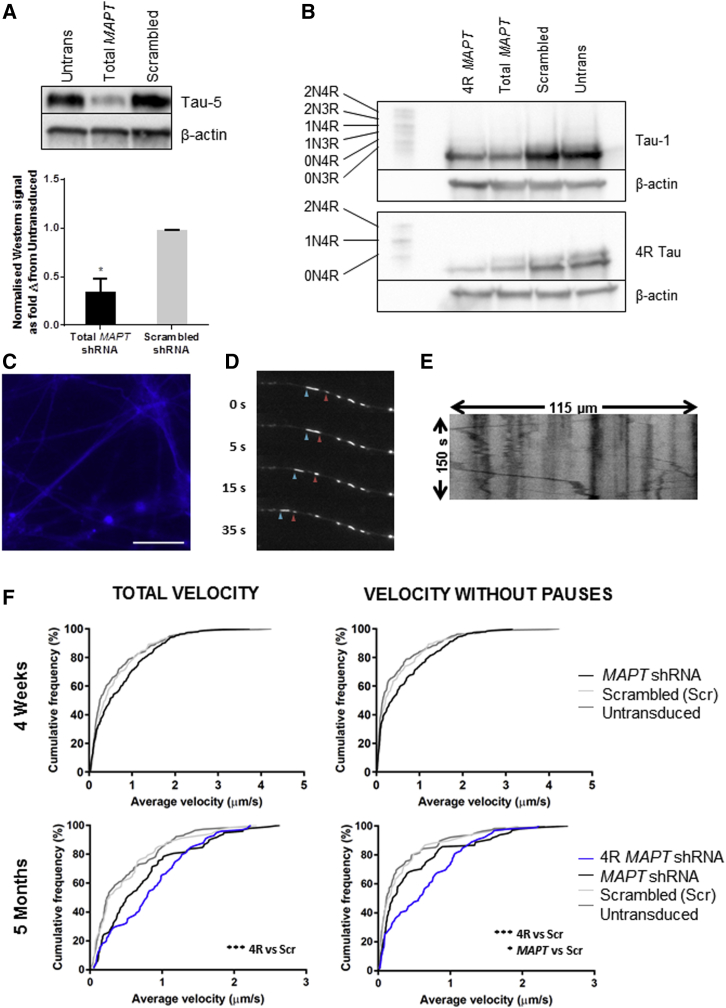
Knockdown of 4R Tau Increases Velocity of Mitochondrial Axonal Transport in iPSC-Derived Dopaminergic Neuronal Cultures Differentiated for 5 Months(A) Western blots showing knockdown of tau protein in dopaminergic neuronal cultures 4 weeks post-transduction. ∗p = 0.0457.(B) Western blots after protein dephosphorylation show knockdown of tau protein and 4R tau isoforms persisting in 5-month dopaminergic neuronal cultures with β-actin loading control.(C) Fluorescence microscopy image of EBFP2 expression during axonal transport live imaging at 5 months. Scale bar, 25 μm.(D) Selected time-lapse fluorescence microscopy images of axonal mitochondria in dopaminergic neuronal cultures stained with MitoTracker Deep Red. Arrowheads show motile mitochondria.(E) Kymograph time-space plot of a trace along the linear path of an axon, from which mitochondrial motility parameters can be determined.(F) Cumulative frequency graphs of average mitochondrial velocity in dopaminergic neuronal cultures at (top) 4 weeks post-transduction and (bottom) 5 months post-transduction. (Left) Average total velocity of each measured motile mitochondrion; (right) average velocity of each measured motile mitochondrion after removal of time when paused. All four graphs were statistically significant in Kruskall-Wallis nonparametric tests: upper left, p = 0.0033; upper right, p = 0.0200; lower left, p < 0.0001; lower right, p < 0.0001. ∗Significance in the follow-up Dunn's multiple comparisons test (nonparametric) compared with scrambled shRNA control: ∗p < 0.05; ∗∗∗p < 0.001. See also Figure S6.